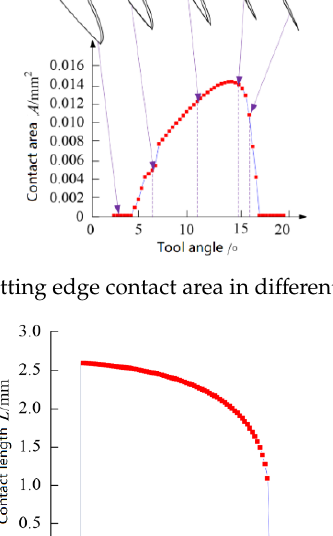
Figure 15. Cutting edge contact area in different tools angles.